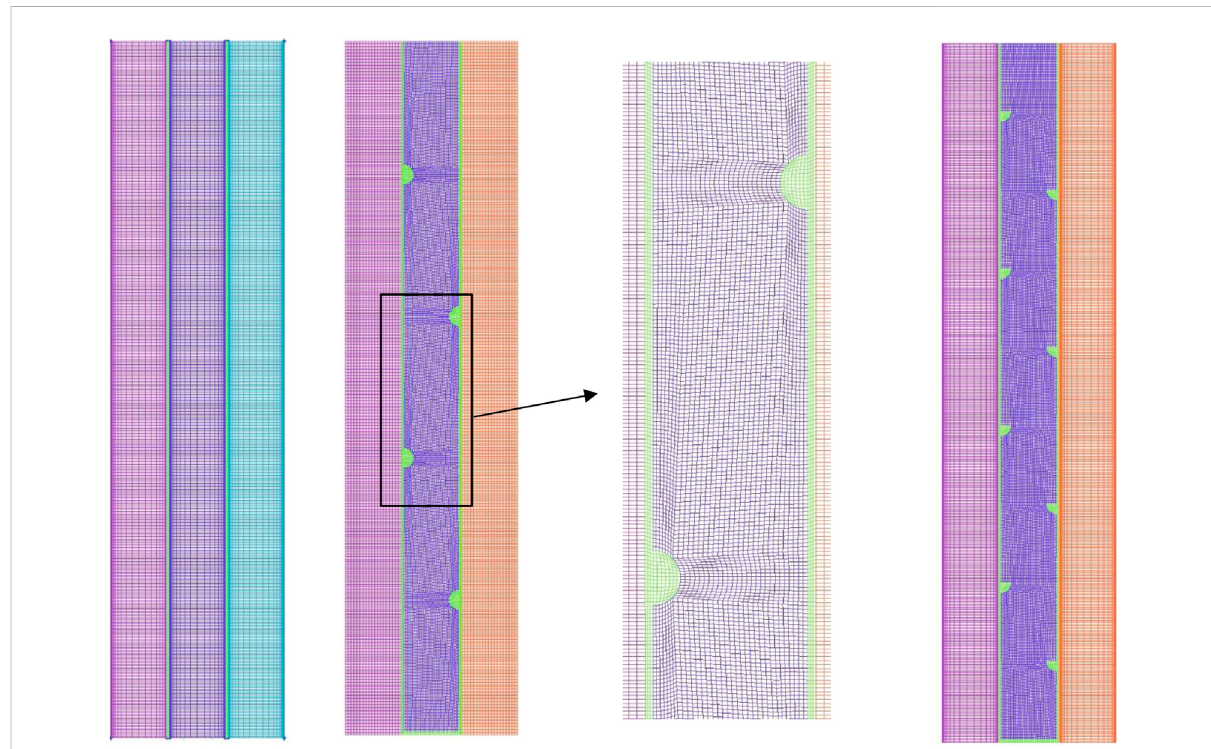
FIGURE 4 Schematic of the mesh for the cases of no- fi n, staggered hemispherical fi ns, and staggered quarter spherical fi ns with an added fi n.